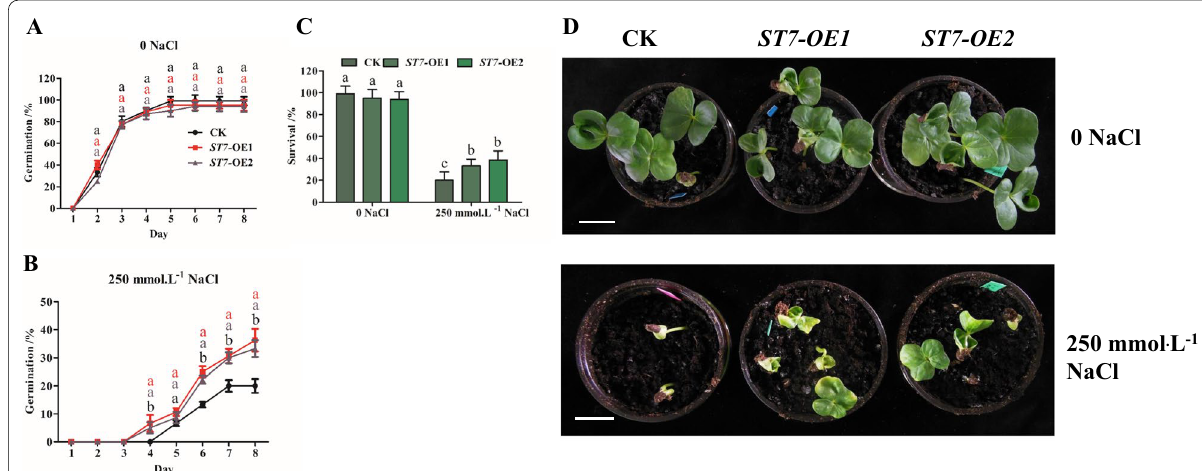
Fig. 1 Expression of ThST7 gene in cotton confers salt tolerance phenotype in seed germination. A Seed germination curve. Seeds of the wild type (CK) and ST7 -OE lines were germinated in soil watered with 0 or 250 mmol L − 1 NaCl for 8 days and germination percentage was recorded · every day. Values are mean SD (10 seeds per replicate, five replicates per treatment). Different letters denote significant differences ( P < 0.05) from ± Duncan’s multiple range tests. B Seedling survival ratio. The above germinated seeds were grown for 2 weeks before seedling survival ratio was recorded. Values are mean SD (10 plants per replicate, five replicates per treatment). Different letters denote significant differences ( P < 0.05) from ± Duncan’s multiple range tests. C Growth of germinated seeds. Bar 4 =